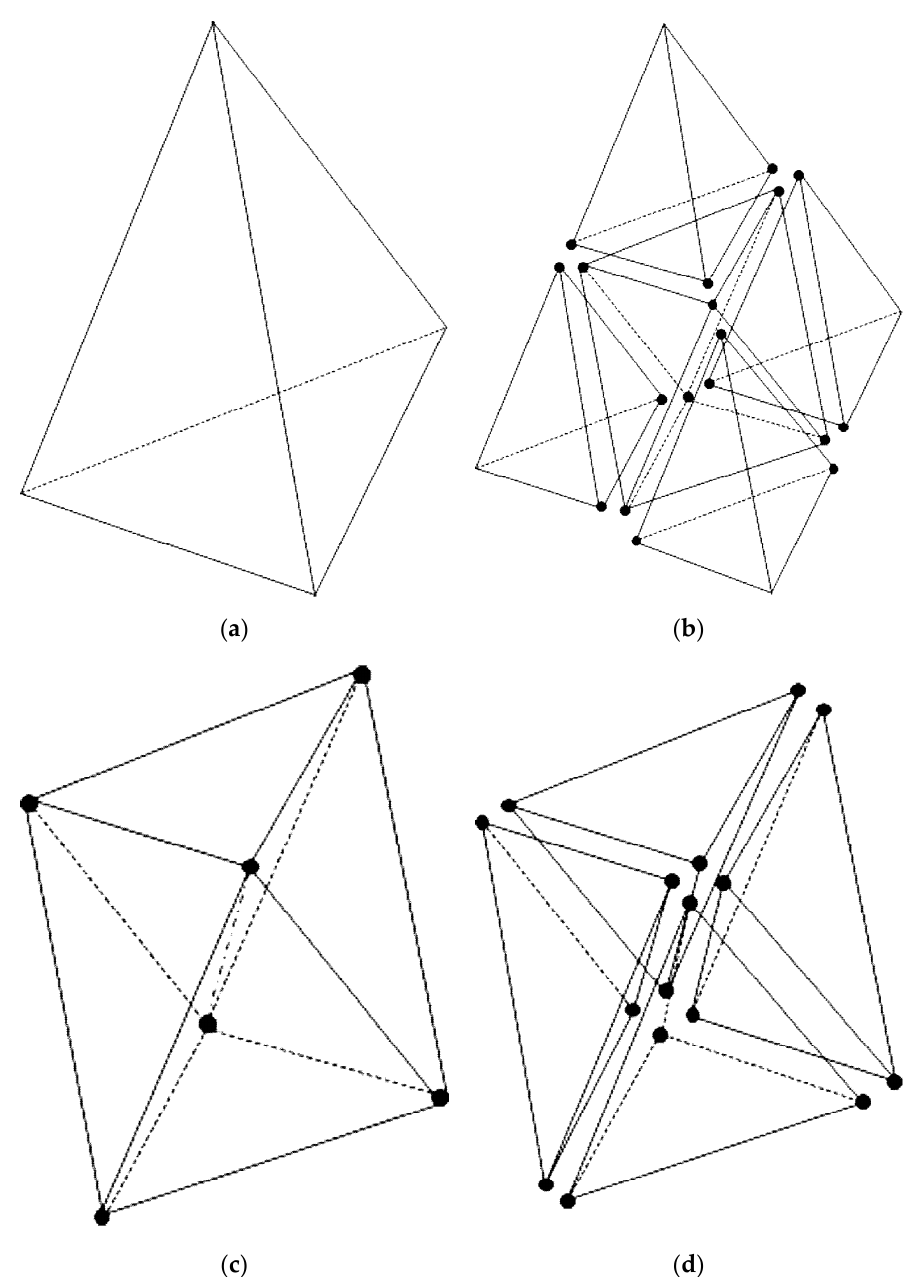
Figure 5. The sub-division of a tetrahedron. ( a ) Original tetrahedron; ( b ) Initial subdivision; ( c ) Central octahedron; ( d ) Subdivision of central octahedron.